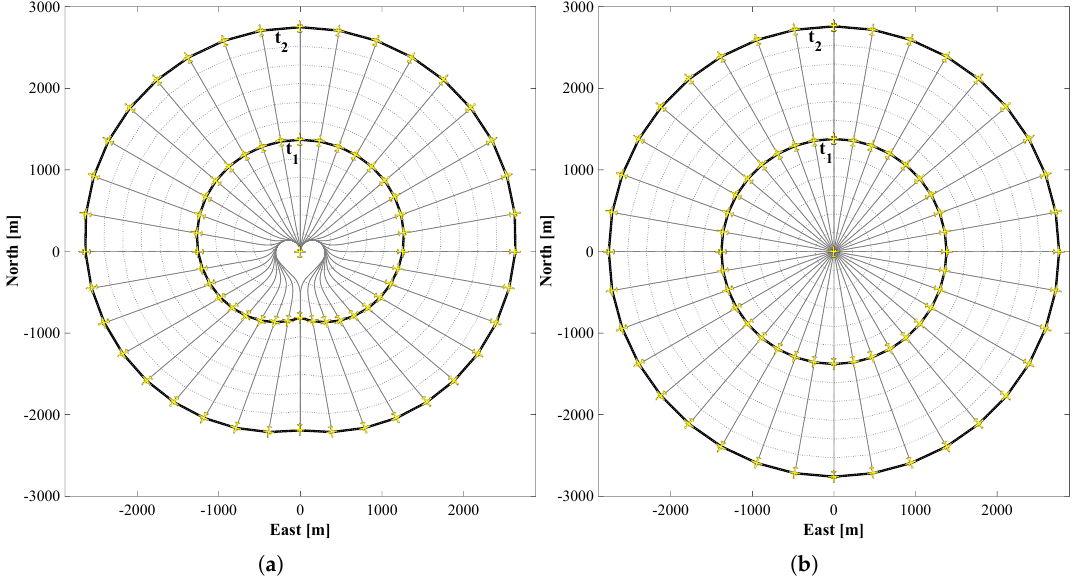
Figure 2. Future states are depicted by yellow aircraft symbols. The isochronous progress with V T = V G = 23 m/s is shown with black lines for t 1 = 60 s and t 2 = 120 s. ( a ) The results of the flight simulation with a maximum bank angle of | µ max | = 19 ◦ compared to ( b ) approximated